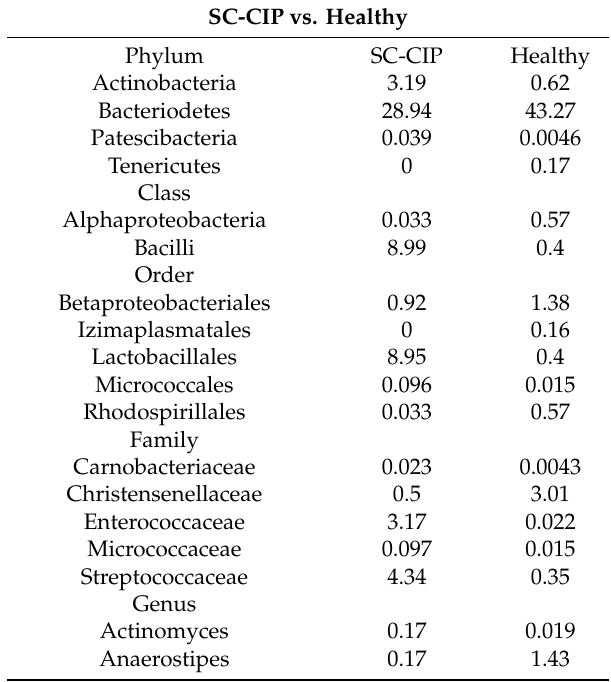
Table 5. Taxonomic di ff erences found with analysis of composition of microbiomes between SC-CIP and healthy groups on all taxonomic